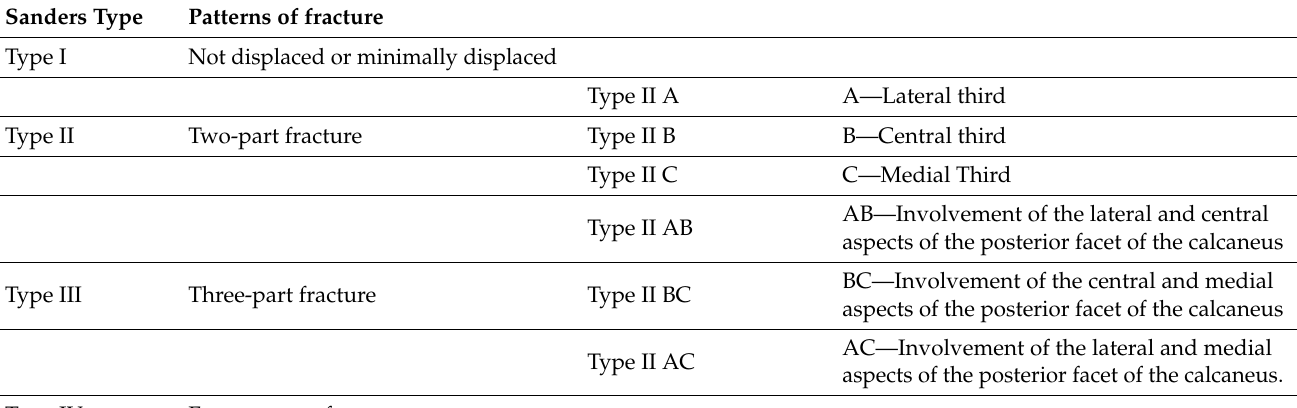
Table 1. The Sanders classification of intra-articular fractures of the calcaneus is based on the number and location of the intra-articular fractures using semicoronal CT images. Fracture lines A, B, and C describe the position of the primary fracture line in relation to the posterior facet and the subtalar